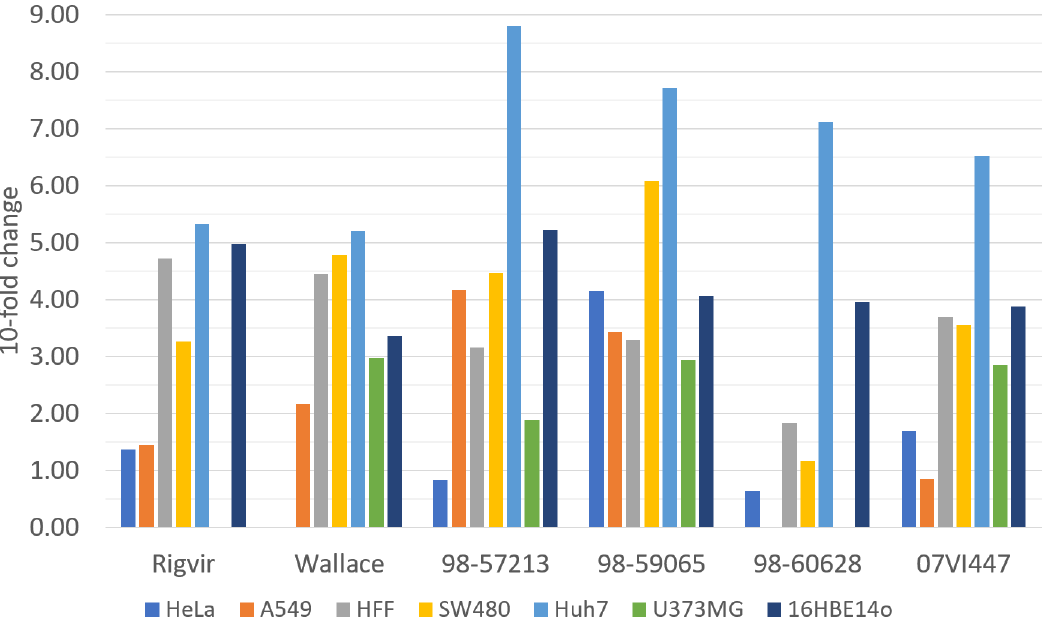
Figure 5. Number of 10-fold changes observed in virus amounts based on RT-qPCR Ct values of Rigvir ® and other echovirus 7 isolates between 1 h and 72 h time